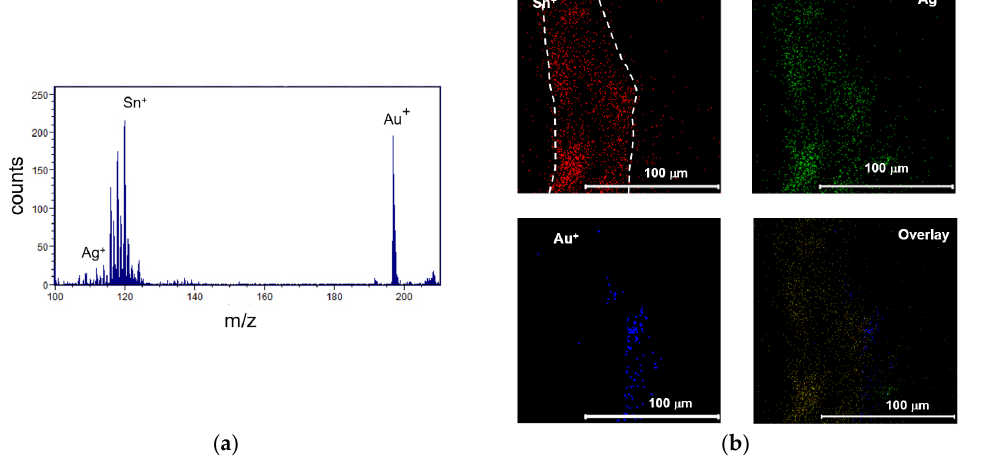
Figure 6. ( a ) ToF-SIMS mass spectrum for the m / z regions of tin, silver and gold. ( b ) Maps showing total Sn + (red), Ag + (green) and Au + (blue) distributions. The dashed white line marks the zone of the Sn lamina. The overlay of the Sn, Ag and Au ion distributions is shown in the last image. The total count rates are 1904, 1797 and 115 for Sn, Ag and Au, respectively.